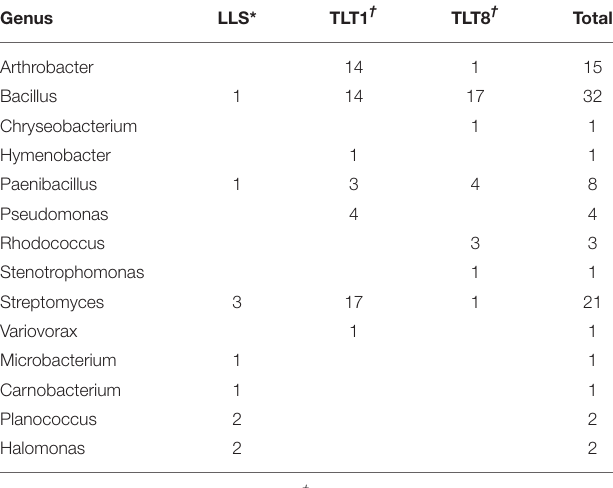
TABLE 2 | Isolates categorized by their genus assigned by 16S rRNA similarity index and isolated location.